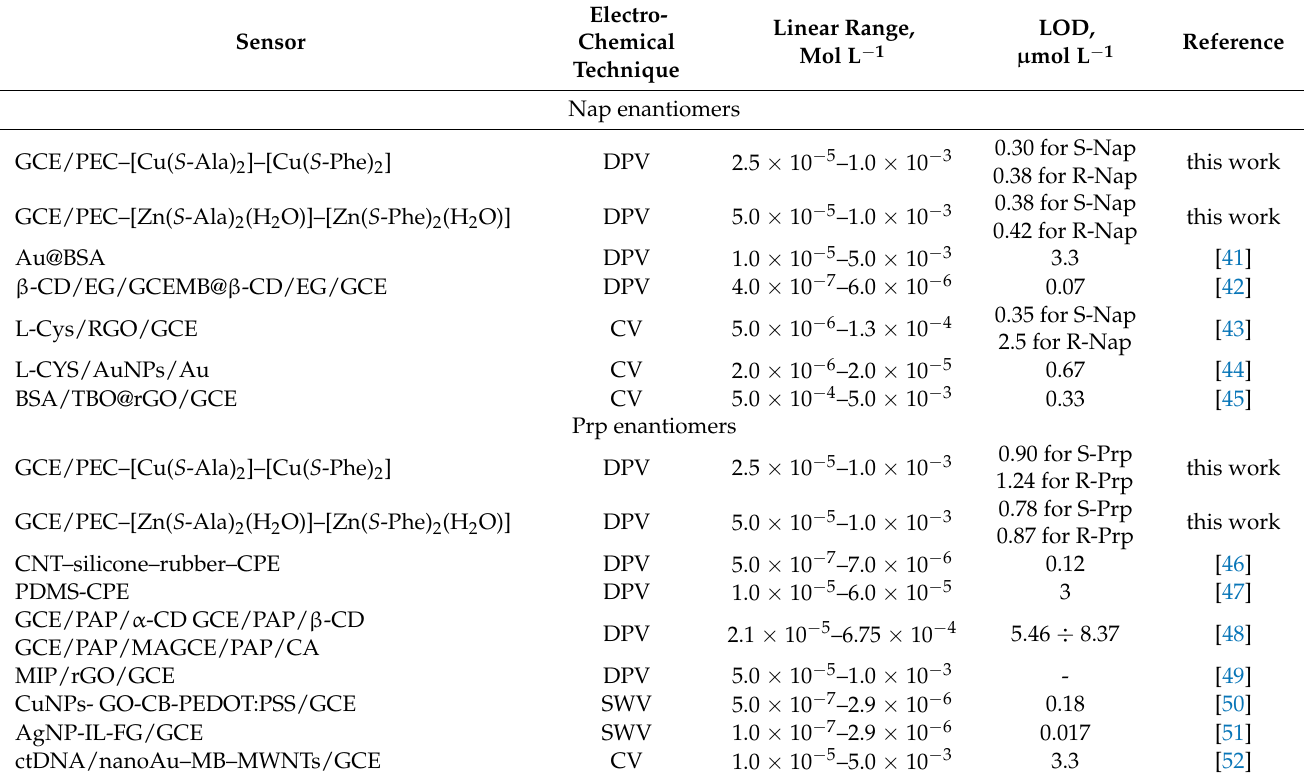
Table 3. Comparison of various modified electrodes for recognition of Prp and Nap enantiomers.